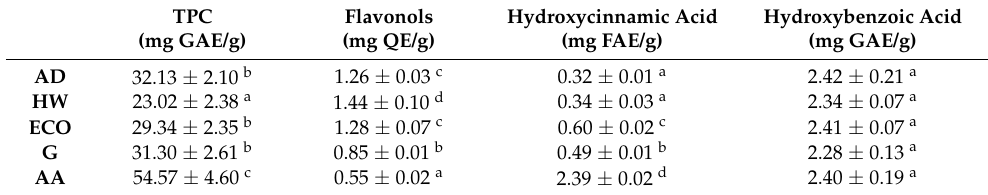
Table 2. TPC (Q-Fast Blue) and phenolic families of kiwi varieties, expressed as mg/g (dry